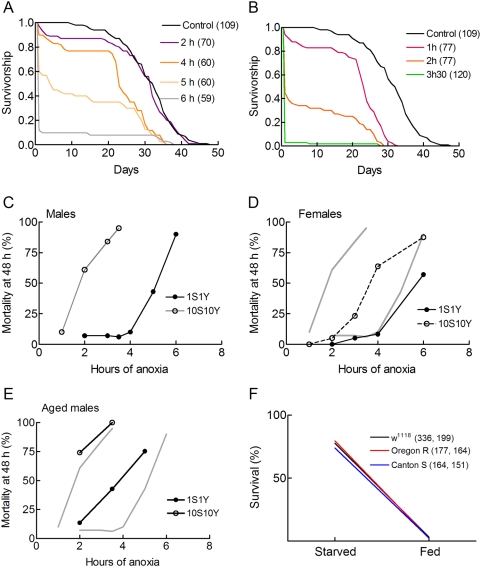
Influence of the duration of anoxia on mortality.A, B. Male w1118 flies were adapted for 2 days to a 1S1Y diet (A) or a 10S10Y diet (B), exposed to the indicated times of anoxia, reoxygenated, switched to a 10S10Y diet and survivorship curves were determined. Sample sizes are indicated in parentheses. Note that A/R stresses mainly reduce the short term mortality and have less effect on maximum longevities. C–E. Relationship between the duration of anoxia and the short term mortality for young male flies (C), young female flies (D) and 1 month old male flies (E). In panels D and E, the grey lines reproduce the curves obtained for young males (panel C). Sample sizes were 40–113. Aged males were maintained on a standard food medium for 1 month, switched either to a 1S1Y or a 10S10Y diet for two days and then A/R stressed. F. Norms of reaction of flies of different strains as indicated. Young male flies were used. Sample sizes (starved, fed) are indicated in parentheses. Differences between strains are not statistically significant.